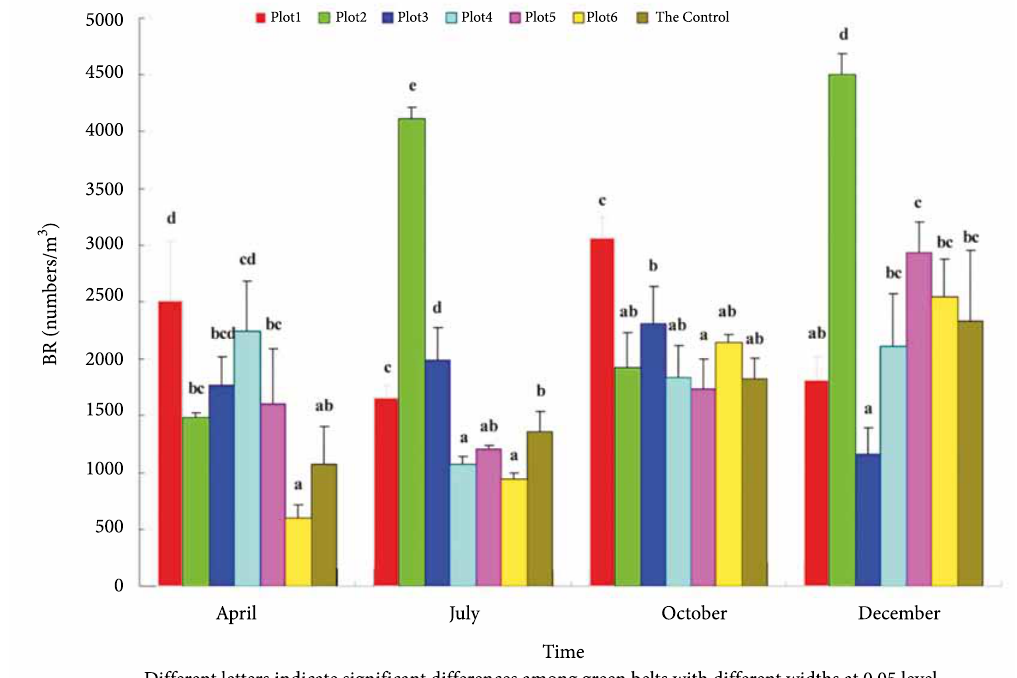
Fig. 14. The 3-day average BR in the green belts